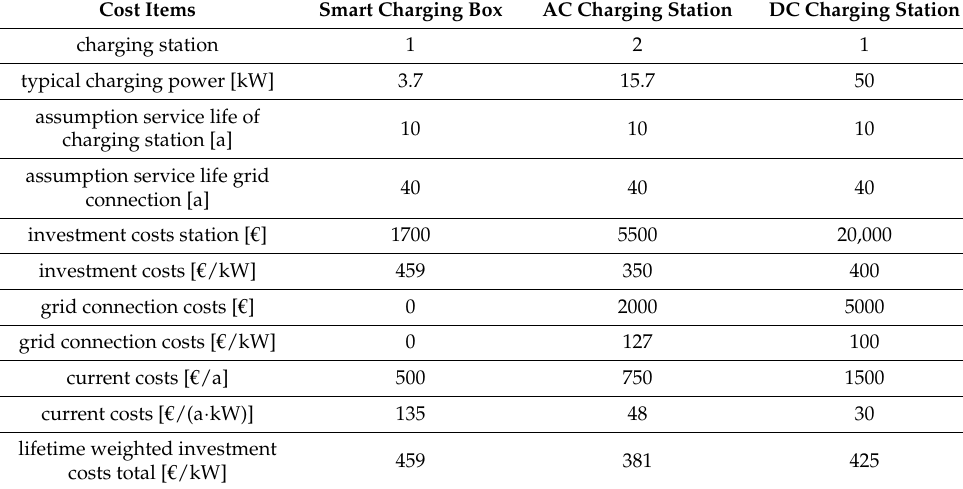
Table 2. Charging station infrastructure costs for electric vehicles based on [24,25].